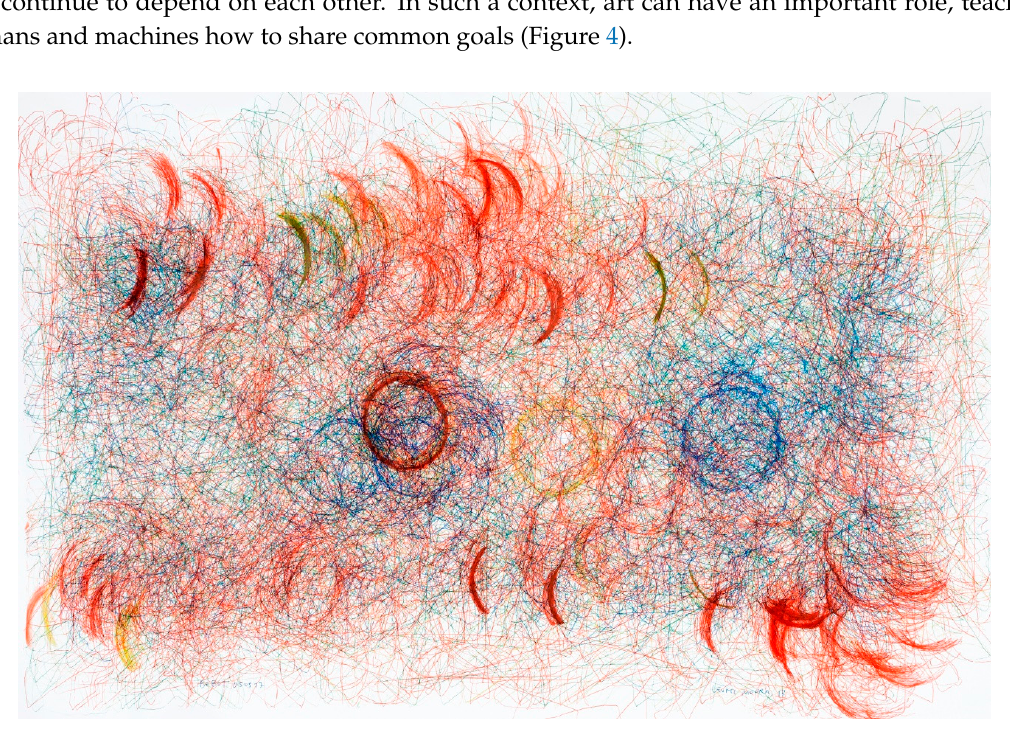
Figure 4. Bebot , 2017, ink on canvas, 300 cm × 470 cm. ©2017 Robotarium and used by permission. Art-making machines are also important beyond the creation of beauty or emotional stimulation,